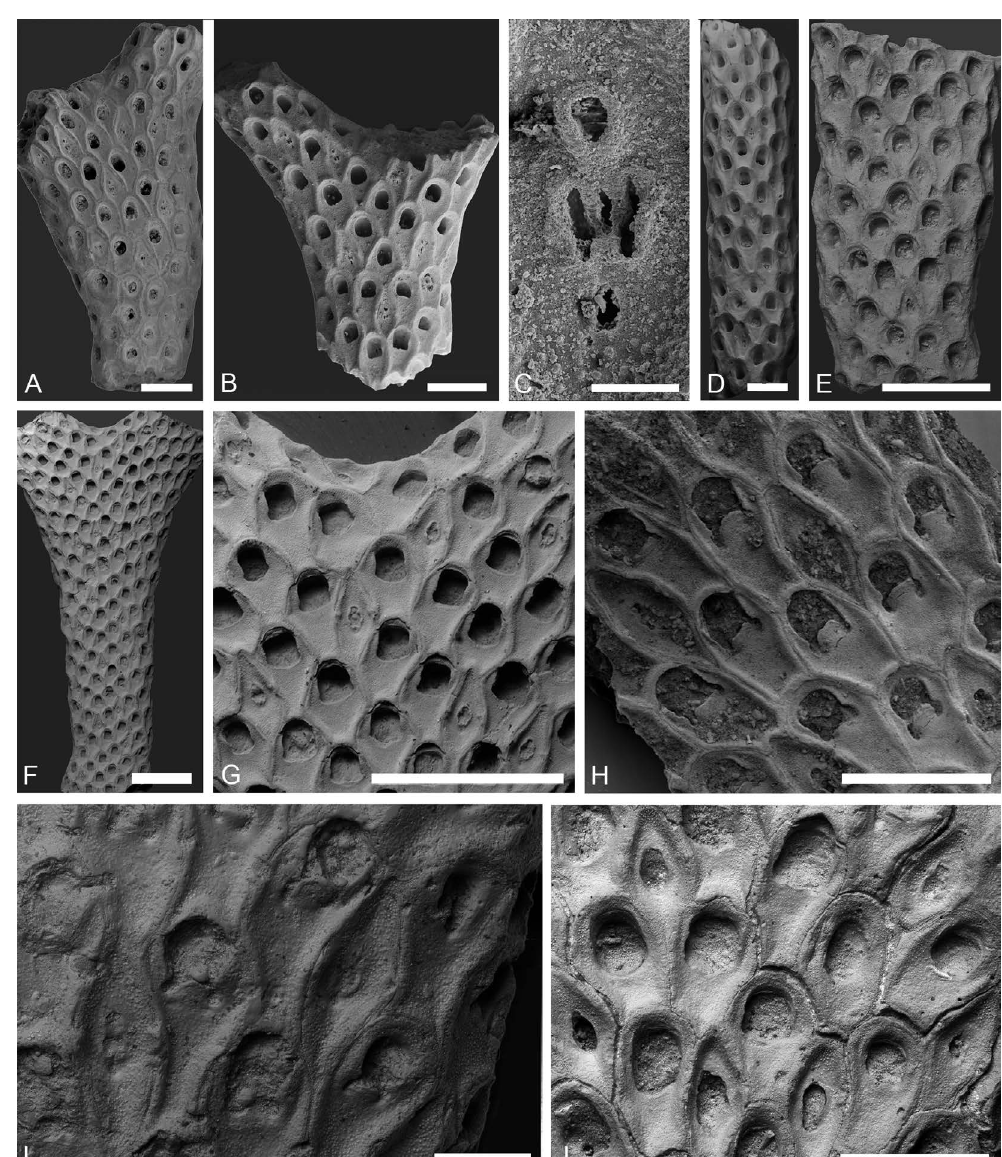
Fig. 18. Rhagasostoma rowei (Brydone, 1906). A . SMF 29932, early Maastrichtian, Rügen, Germany, overview of erect bifoliate stem-like then dichotomously branching colony. B–C . SMF 29925, early Maastrichtian, Island of Møn, Denmark. B . Overview of erect bifoliate stem-like then dichotomously branching colony. C . Opesia and opesiules of avicularium. D . SMF 29933, late Maastrichtian, former brick factory, Hamburg-Hummelsbüttel, Germany, showing the parallel-sided base of erect bifoliate colony with rare avicularia. E . TsNIGR Museum 36/9757, late Maastrichtian, Turkmenistan, Tuarkyr, showing the parallel-sided base of erect bifoliate colony with rare avicularia. F–H . Maastrichtian, Kazakhstan, Mangyshlak Peninsula. F–G . PIN 3421/1009. F . Erect bifoliate colony, almost parallel- sided but widening distally. G . The widest part of the colony showing autozooids and numerous avicularia. H . PIN 3421/1008, showing autozooids with long cryptocystal tongues, and avicularia. I . TsNIGR Museum 32/9757, late Maastrichtian, Turkmenistan, western Kopetdag, showing ovicellate (arrows) and non-ovicellate autozooids with long cryptocystal tongues, and avicularia. J . PIN 5502/3050, Maastrichtian, Kazakhstan, northern Aral Sea Region, showing autozooids and avicularia. Scale bars: A–B, D, H, J = 1 mm; C = 100 µm; E–G = 2 mm; I = 500